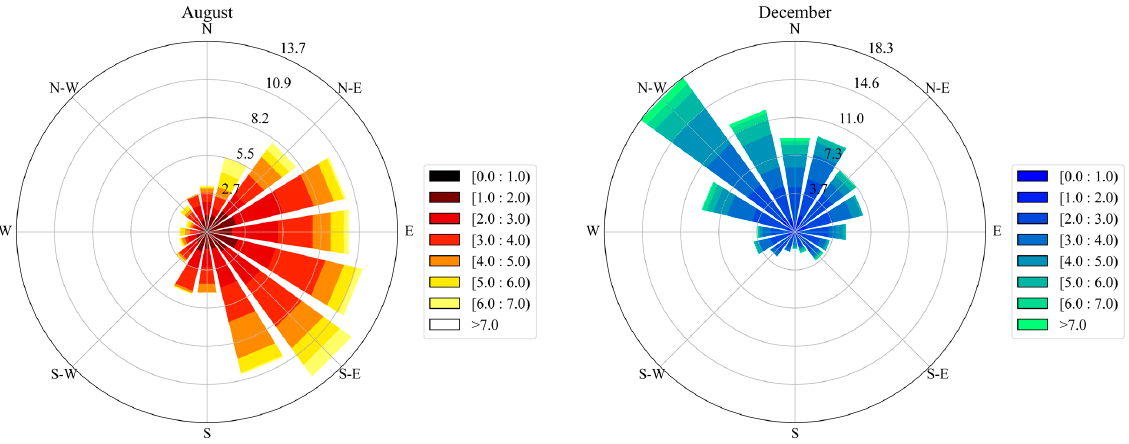
Figure 13. Five-year mean wind rose charts for the YRE in August and December, and in each direction of the polar coordinates, the frequency of the wind direction is expressed by the length of the polar coordinates. At the same time, the distribution of wind speed in different wind directions is expressed by the color change from deep to shallow.